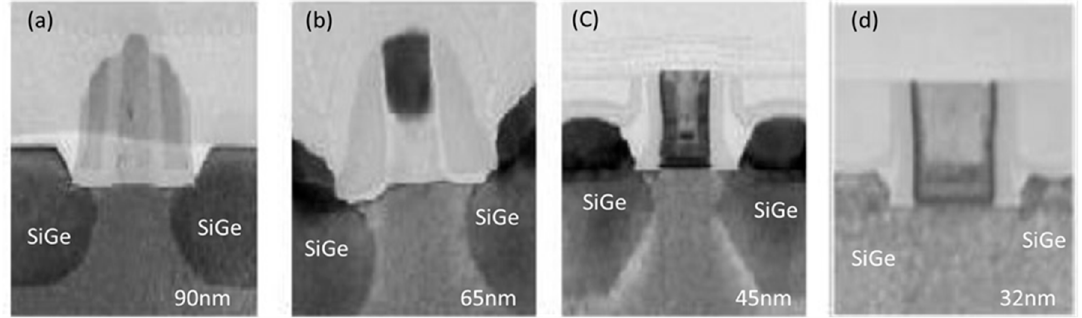
Figure 5. The evolution of nano-scaled transistors having SiGe as stressor material in source/drain (S/D) for each node ( a ) 90 nm, ( b ) 65 nm, ( c ) 45 nm, and ( d ) 32 nm. Sigma shape recess was introduced for the first time in 45 nm. Reproduced with permission from [44]. Copyright SPIE, 2016.